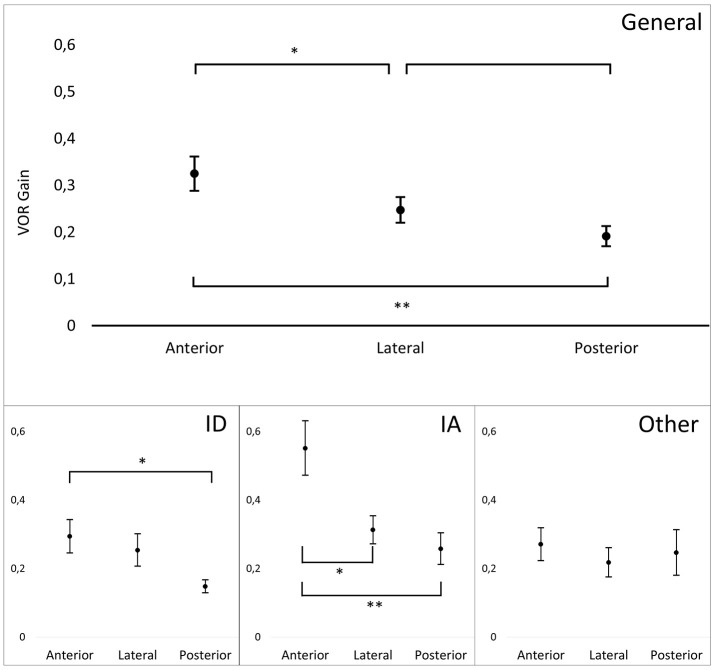
Mean VOR gains for pairs of canals during vHIT in different patient groups. General, General population (n = 20); ID, patients with Idiopathic BVH (n = 10); IA, Patients with gentamicin induced BVH (n = 4); Other, Other etiologies (n = 6). T bar represents standard error. Significant differences are indicate by one (p < 0.05) or two (p < 0.01) asterisks.